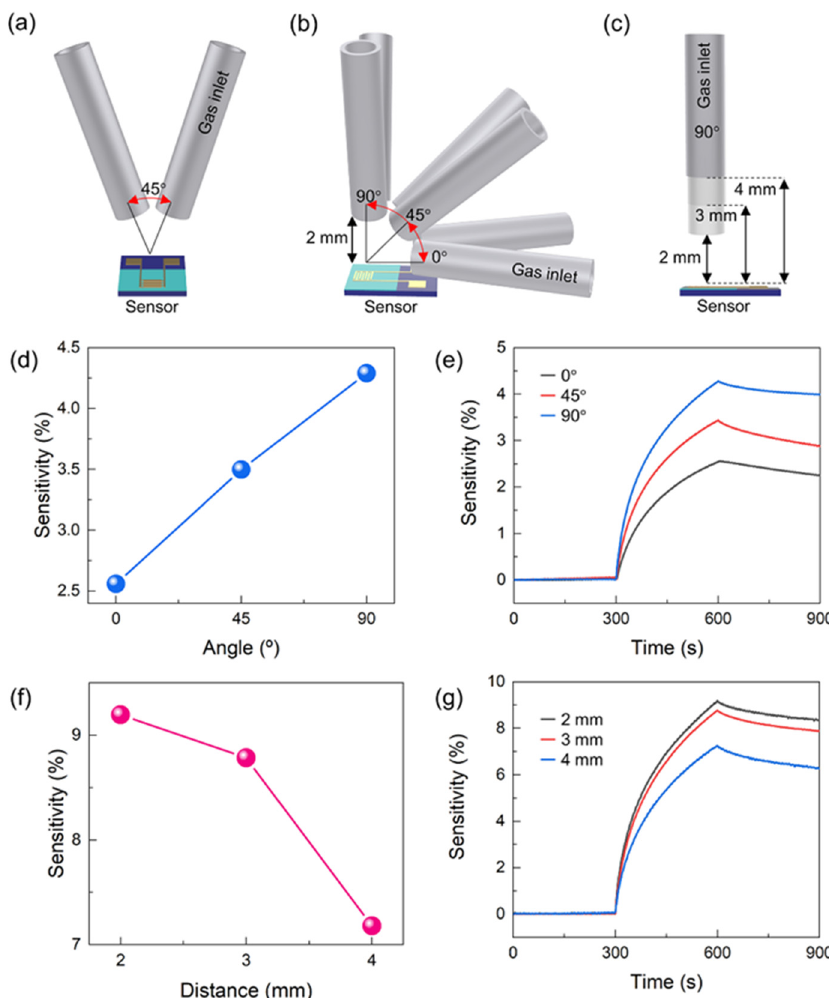
Figure 3. Schematic representation of gas inlet-gas sensor geometry showing ( a ) the angle between the two-gas inlets (front view), ( b ) the angle, and ( c ) the distance between the gas inlet and the sensor (side view). The sensing responses of the MoS 2 gas sensor to 5 ppm of the analyte NO 2 ( d , e ) at different angles between the gas inlet and the sensor (0°, 45°, and 90°) and ( f , g ) at different distances between the gas inlet and the sensor (2, 3, and 4 mm) at the gas inlet angle of 90° under room temperature (21 °C).